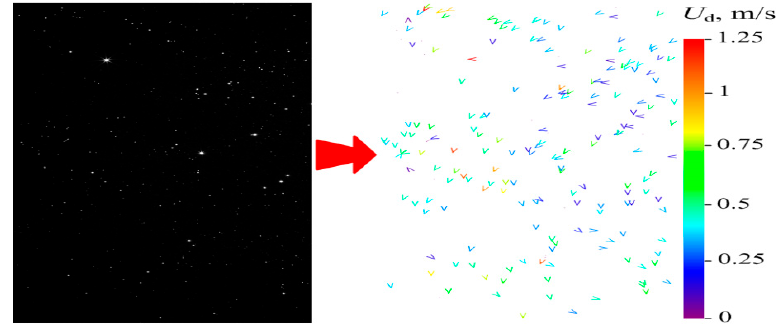
Figure 2. Video image of TiO 2 particles ( left ) and the result of its processing by PTV ( right ). 4. Measurement